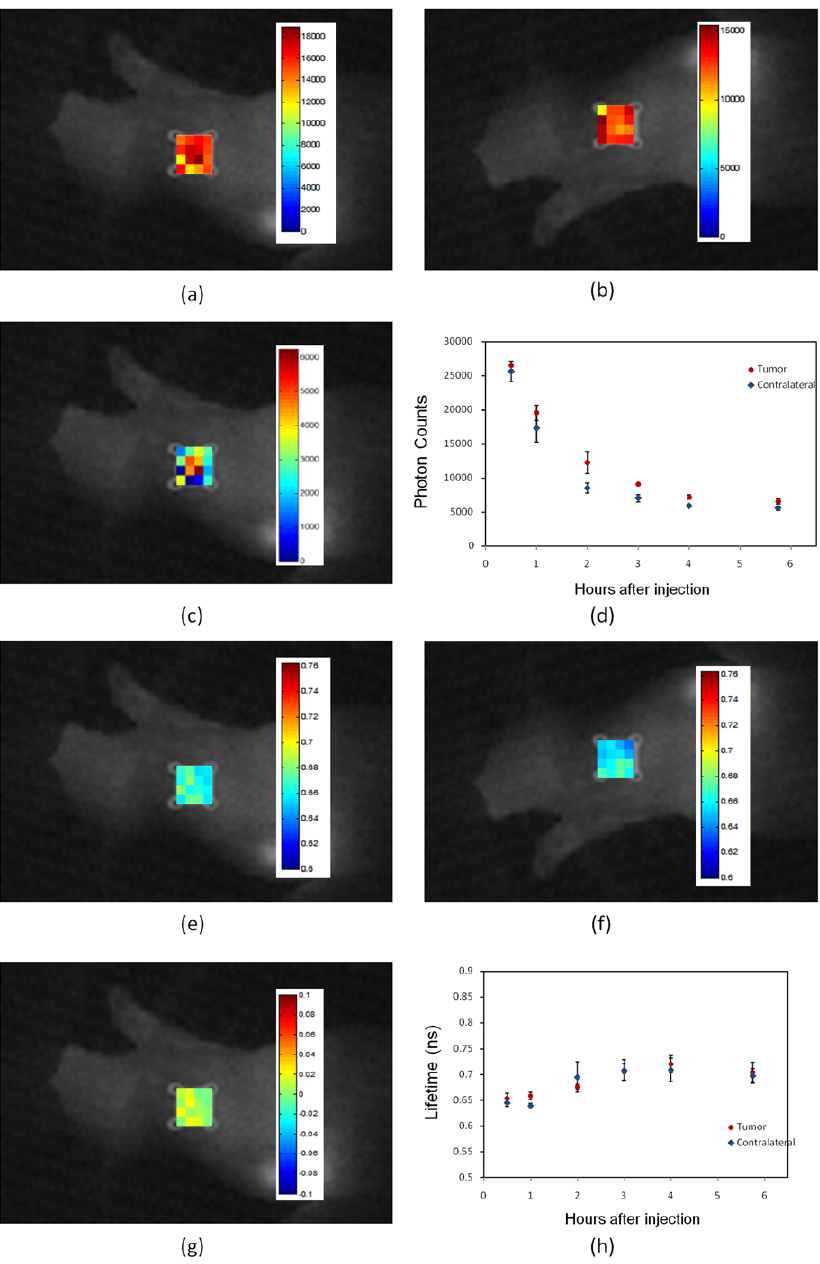
Figure 7. Invivo fluorescence imaging of xenograft mouse with high HER2 expressing human tumor model (NCI-N87) after injection of the HER2-nonspecific Affibody H (His6-Z Taq :GS-Cys) conjugated to Dylight750. ( A ) Fluorescence intensity map at the tumor region. ( B ) Fluorescence intensity map at the contralateral site ( C ) The difference of fluorescence intensity at the tumor region and the contralateral site, mapped on the tumor region. ( D ) Pharmacokinetics of the fluorescence intensity at the tumor region and contralateral site after the injection over time. The data in Figs. ( D ) and ( H ) are the average data of three mice. Markers show the average and bars show the standard deviation. ( E ) Fluorescence lifetime map at the tumor region. ( F ) Fluorescence lifetime map at the contralateral site. ( G ) The difference of fluorescent lifetime at the tumor and the contralateral site mapped on the tumor region. ( E ) Pharmacokinetics of the fluorescent lifetime at the tumor region and contralateral site after injection over